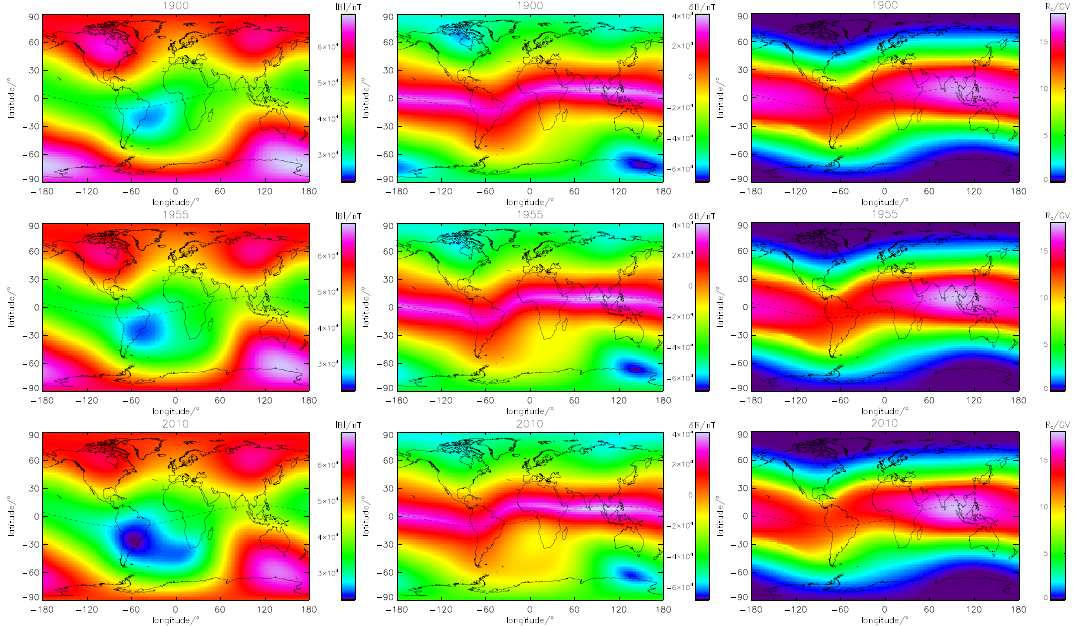
Fig. 2. The three parameters | B | (left panels), δB (middle panels) and R C (right panels) of the magnetic field configuration using the IGRF model for the years 1900 (upper panels), 1955 (middle panels) and 2010 (lower panels). A detailed description is given in the text.